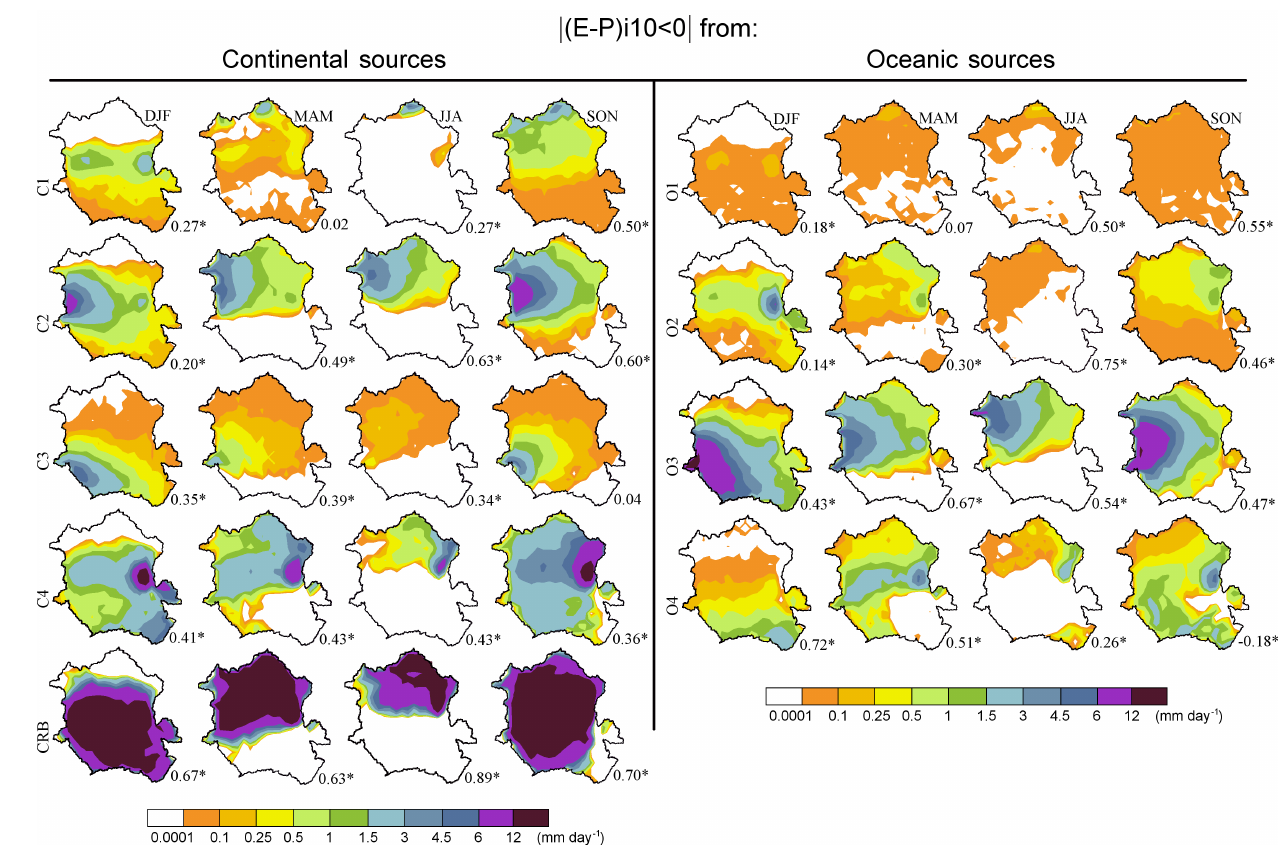
Figure 10. Seasonal mean | ( E − P ) i 10 < 0 | (mmday − 1 ) integrated forward from the moisture sources over the CRB for December–February (DJF), March–May (MAM), June–August (JJA), and September–November (SON). The number in the bottom-right corner of each plot indicates the correlation with the mean precipitation pattern (asterisks indicate significant values at p< 0 . 05). Period: